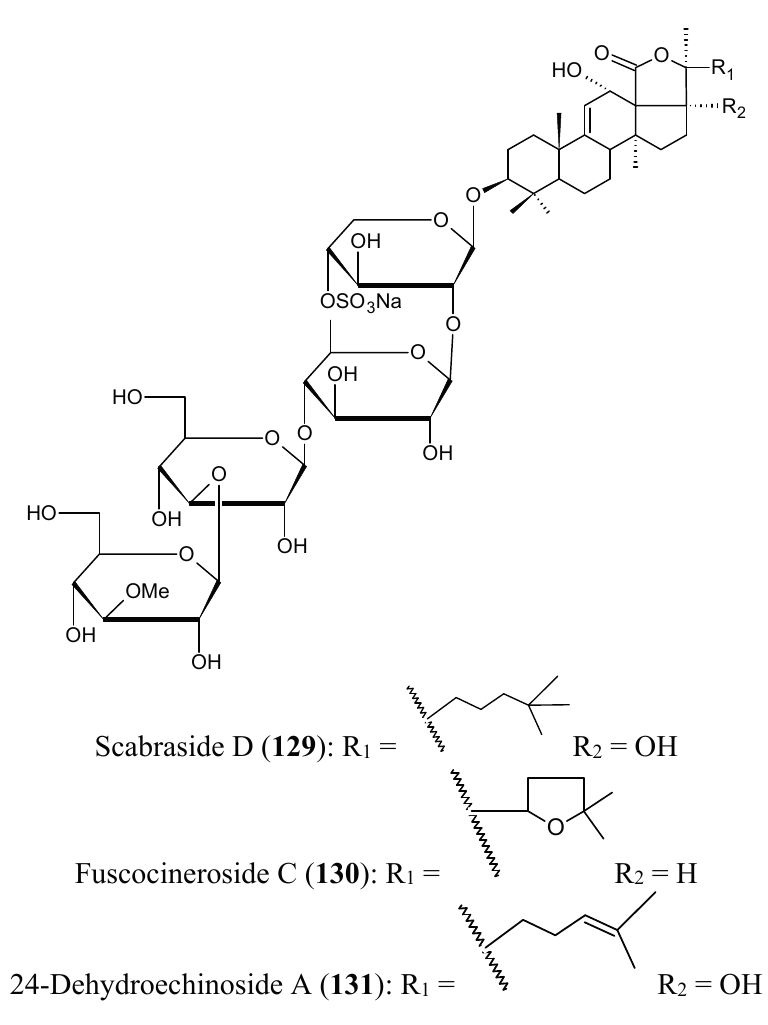
Figure 45. Triterpene glycosides 129 – 131